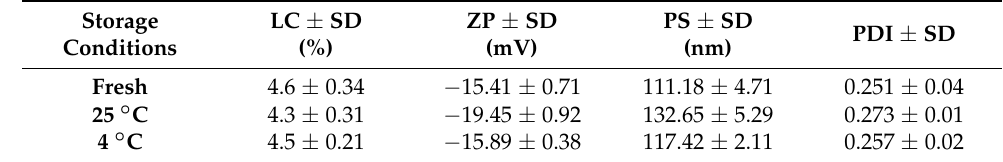
Table 11. Average LC, ZP, PS, and PDI of the optimized NIC–NLC formula after storage for one months at different storage condition in comparison to fresh